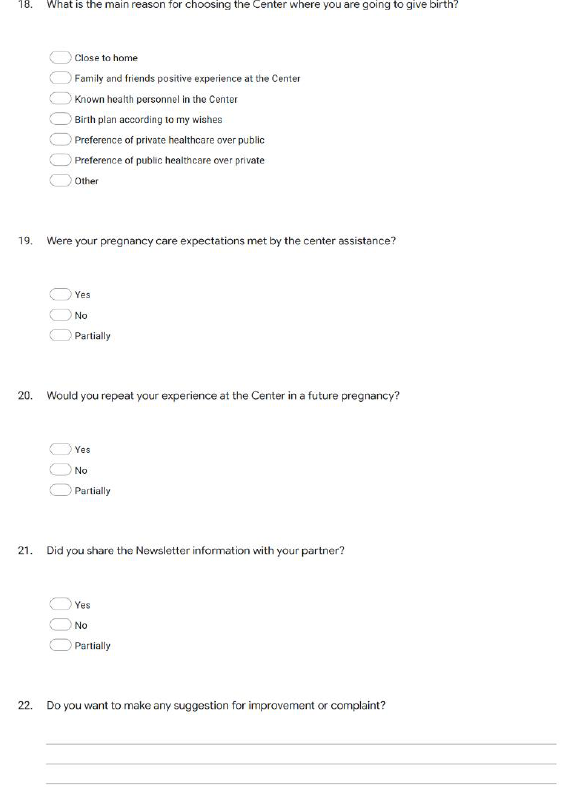
Figure A3. Survey. Figure A3.